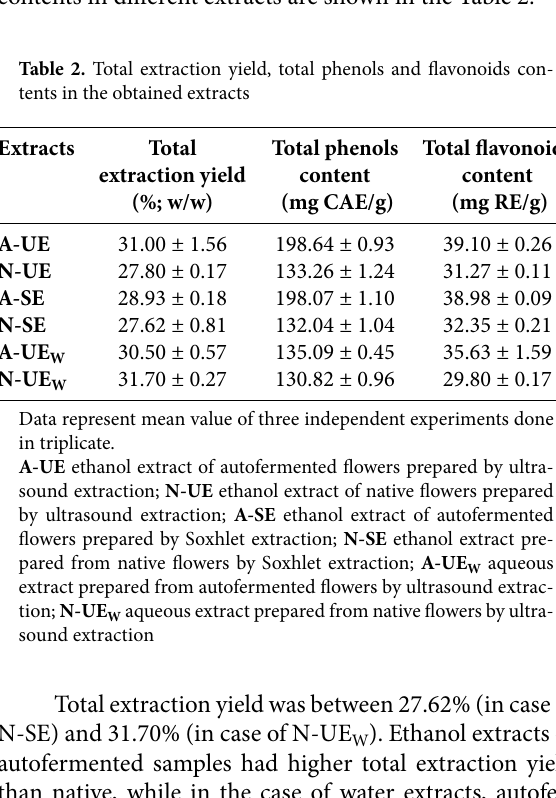
Table 2. Total extraction yield, total phenols and flavonoids con- tents in the obtained extracts Extracts Total Total phenols Total flavonoids extraction yield content content (%; w/w) (mg CAE/g) (mg RE/g)